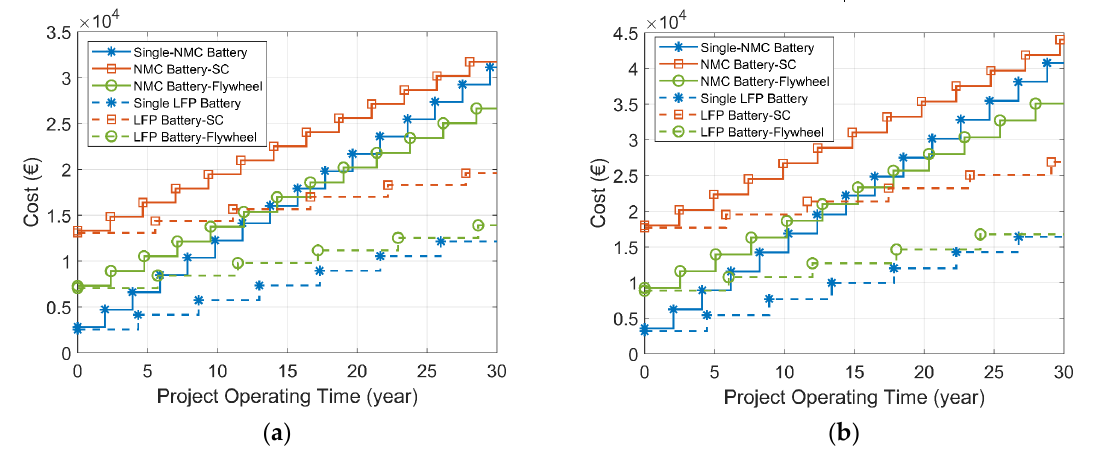
Figure 22. Costs of the single-battery ESS, the battery-SC HESS, and the battery-flywheel HESS over 30 years ( T f is 3600 s). ( a ) Wind-powered household-prosumer system. ( b ) PV-powered household-prosumer system.